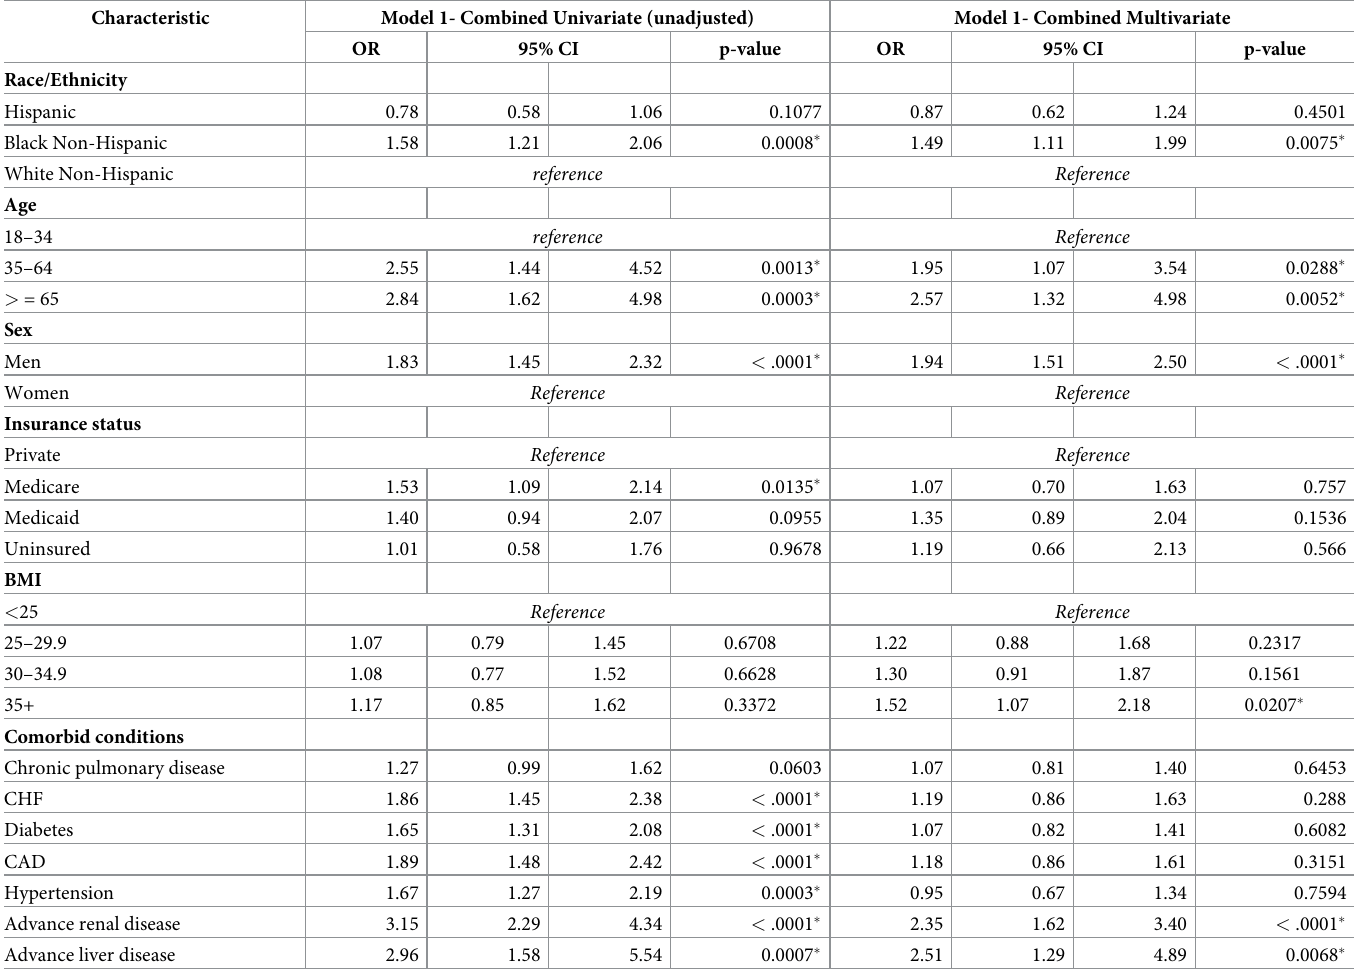
Table 4. Univariate and multivariate regression model results for factors associated with SOFA score within 24 hours �